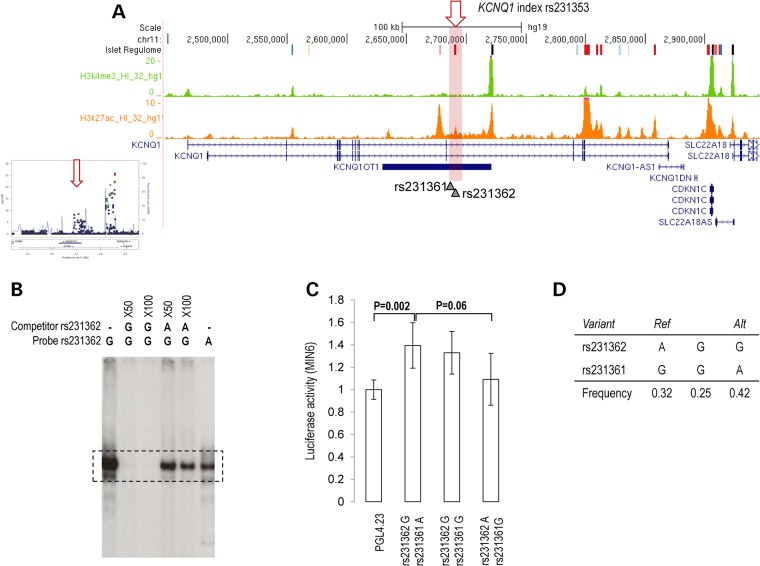
Allele-specific enhancer function at the KCNQ1 locus. (A) At the KCNQ1 association signal indexed by rs231353 (mapping to KCNQ1-OT1), 99% credible set variants rs231362 and rs231361 overlap a human pancreatic islet predicted enhancer characterized by an enrichment of the active histone modification H3K27ac. (B) Electrophoretic mobility shift assay, performed with MIN6 β-cells nuclear extracts, indicates allele-specific protein complex binding to the rs231362 variant. Allele G of the variant rs231362 allows the binding of a protein complex which does not disappear after pre-incubation with an excess of rs231362-A unlabelled oligonucleotide probe (competitor). (C) Luciferase assay shows reduced enhancer activity for haplotypes bearing the allele A compared with allele G of rs231362 in MIN6 β-cells. The data are presented as mean ± standard deviation. Three independent experiments were performed in triplicate, and P-values were calculated by a two-sided Student's t-test. (D) Allele frequencies for credible set variants rs231362 and rs231361.